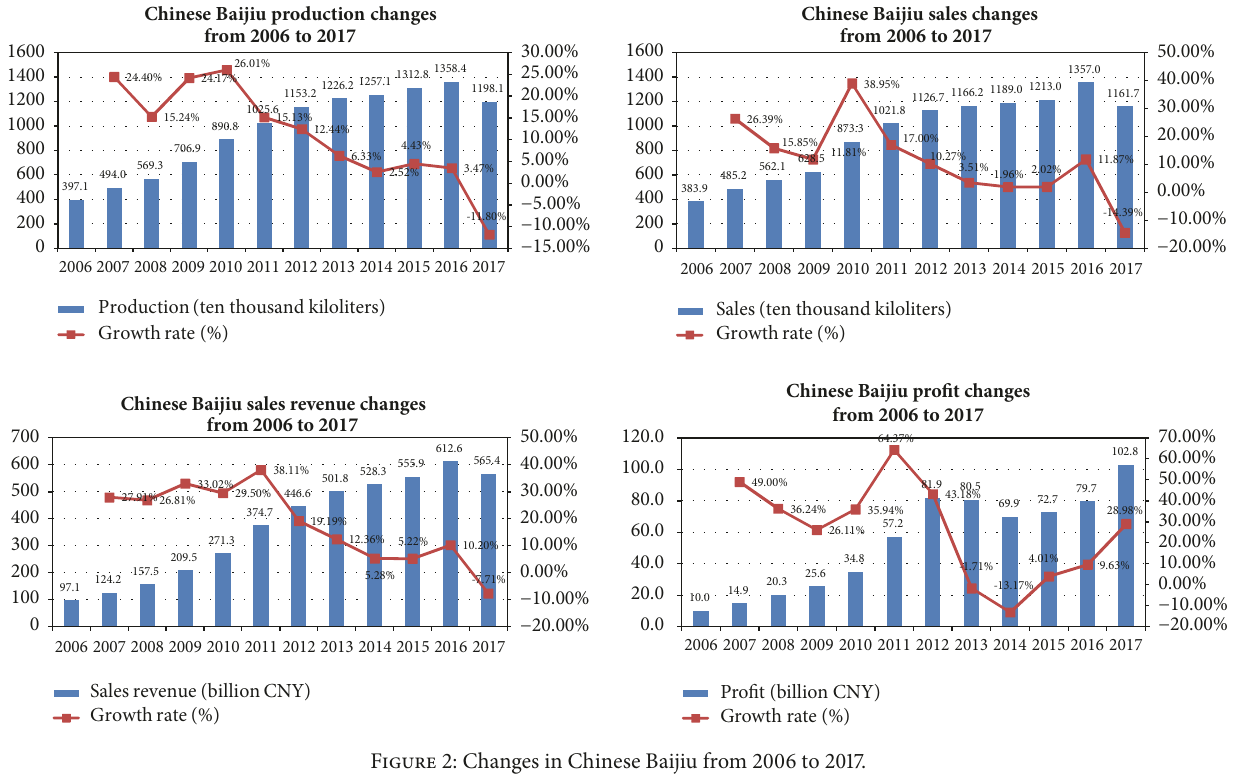
Figure 2: Changes in Chinese Baijiu from 2006 to 2017.